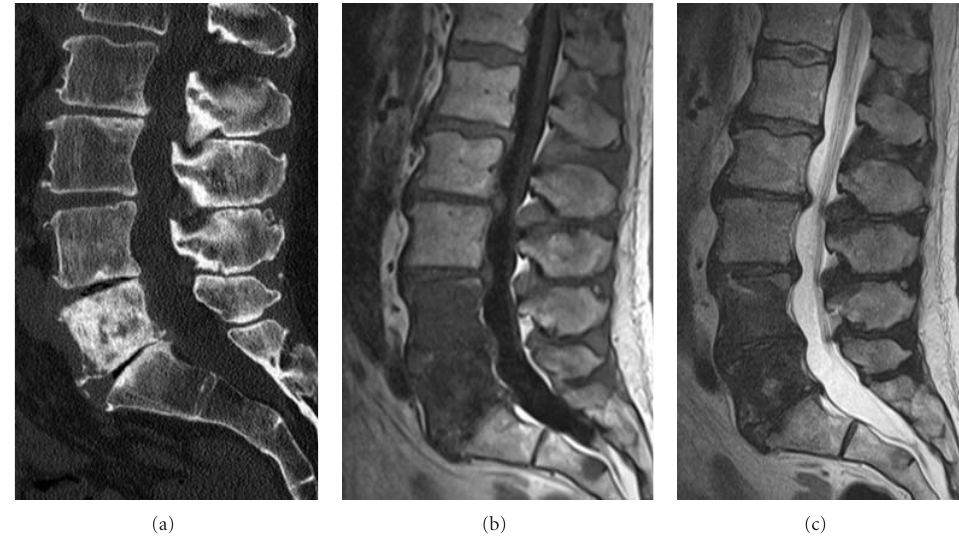
Figure 9: Sagittal CT reformation of the lumbar spines (a) shows a large sclerotic lesion nearly completely involving the L5 vertebral body. Sagittal T1-weighted (b) and T2-weighted (c) images show abnormal hypointense marrow signal in not only the L5 vertebral body but also the L4 vertebral body, corresponding to blastic metastatic